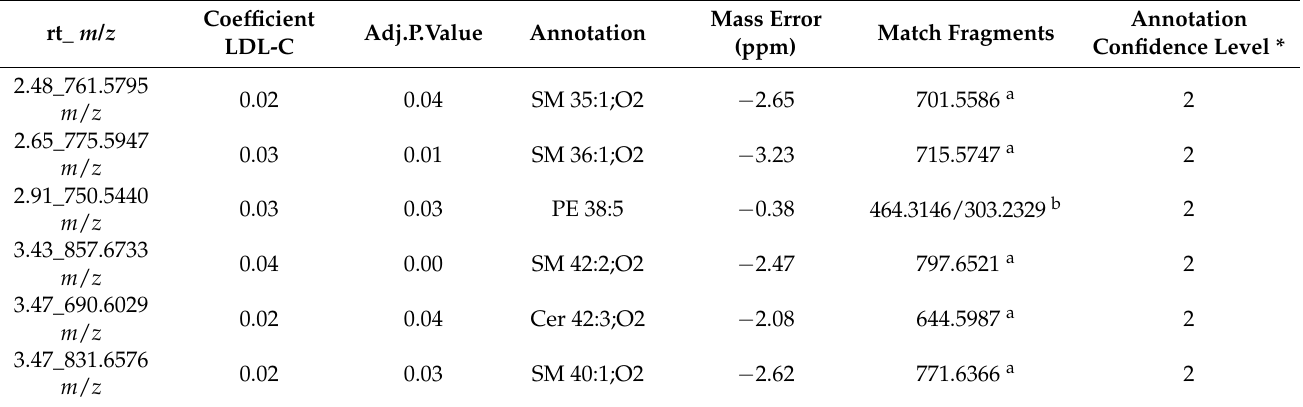
Table 4. MS-annotated lipids with statistically significant associations with LDL-C serum levels.